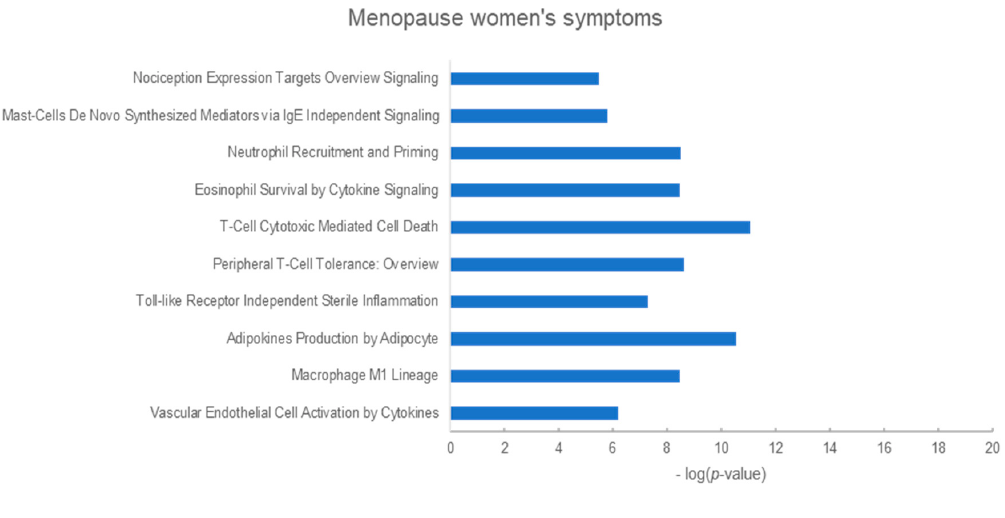
Figure 2. Top 10 enriched pathways of Panax ginseng in metabolic diseases. ( a ) Menopause symptoms ( b ) Blood circulation ( c ) Hyperlipidemia ( d ) Diabetes mellitus. The y-axis shows the significantly enriched pathways of the targets, and the x-axis shows the enrichment scores of the terms ( p < 0.05).